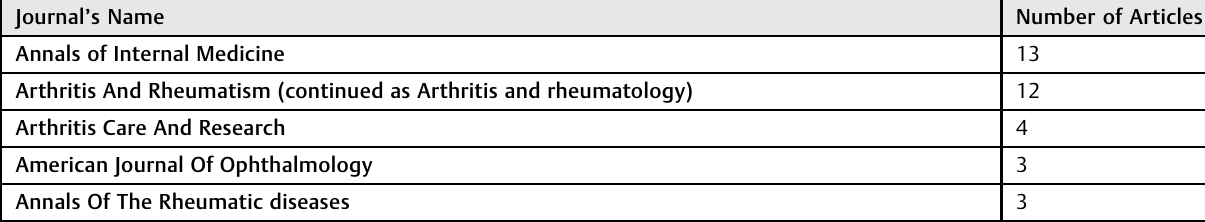
Table 1 Top ranked journals with 3 or more publication on giant cell arteritis in top-50 list